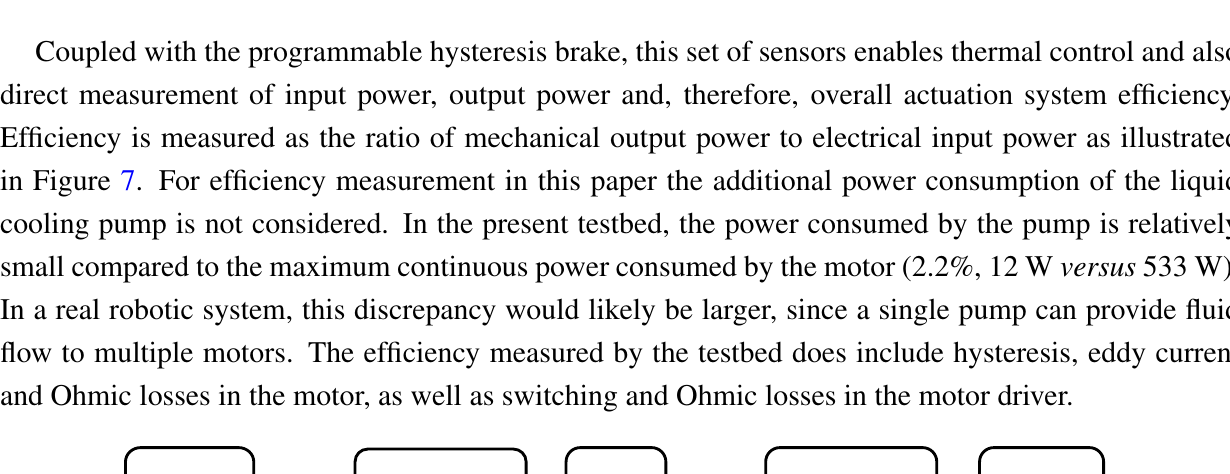
measurementBelt transmission